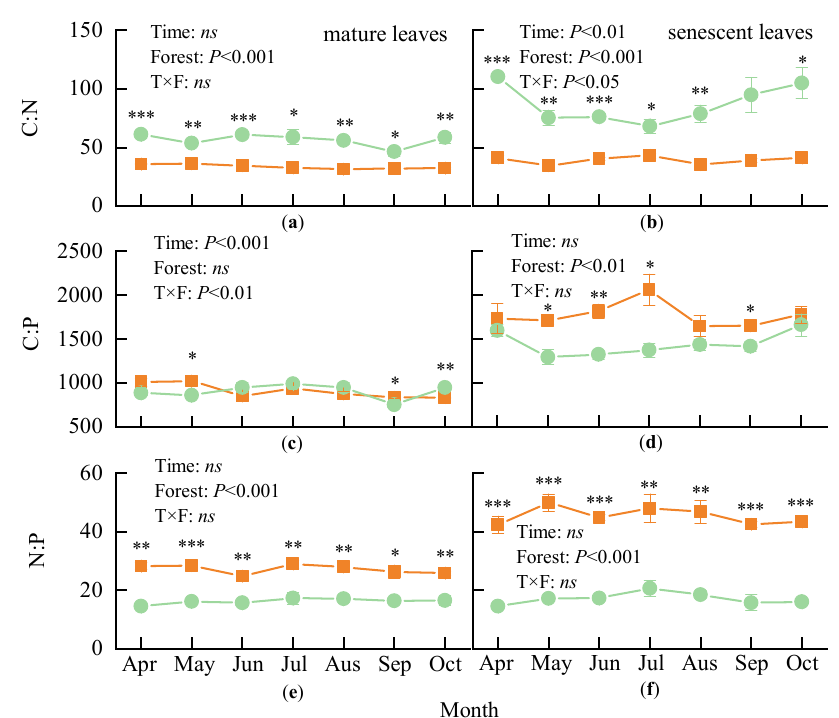
Figure 5. C:N, C:P, and N:P ratios in mature ( a , c , e ) and senescent leaves ( b , d , f ). Each scatter represents the average value of the three replicates ( n = 3). Error bars represent standard errors (SE). The p values show the results from repeated measures ANOVA testing for the effect of forest type over time. ns : not significant. Asterisks denote significant differences between forest types: * p < 0.05, ** p < 0.01, *** p < 0.001.